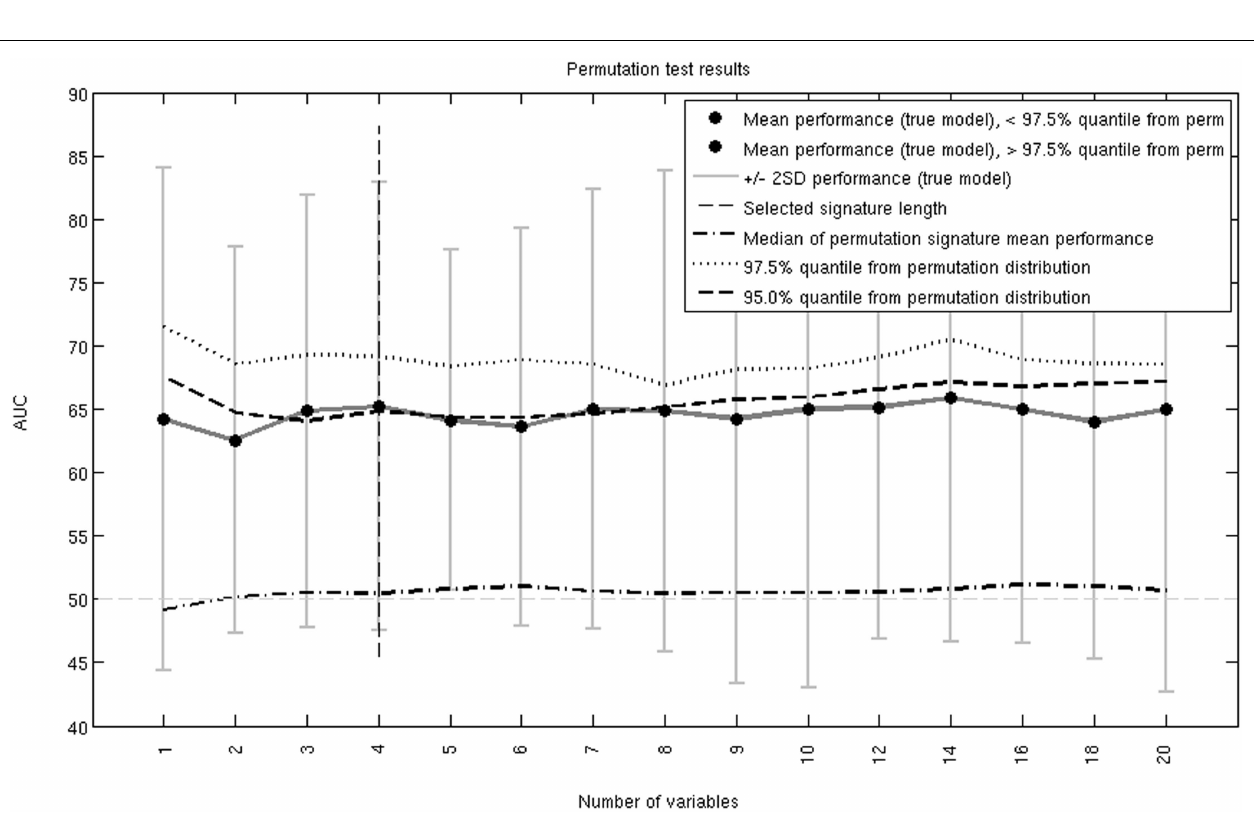
tumor regression score of 2 or 3.At the time of analysis,16 patients were alive without evidence of disease, 9 were alive with evidence of disease, 4 were alive with unknown disease status, 1 died with evidence of disease, and 1 died with no evidence of